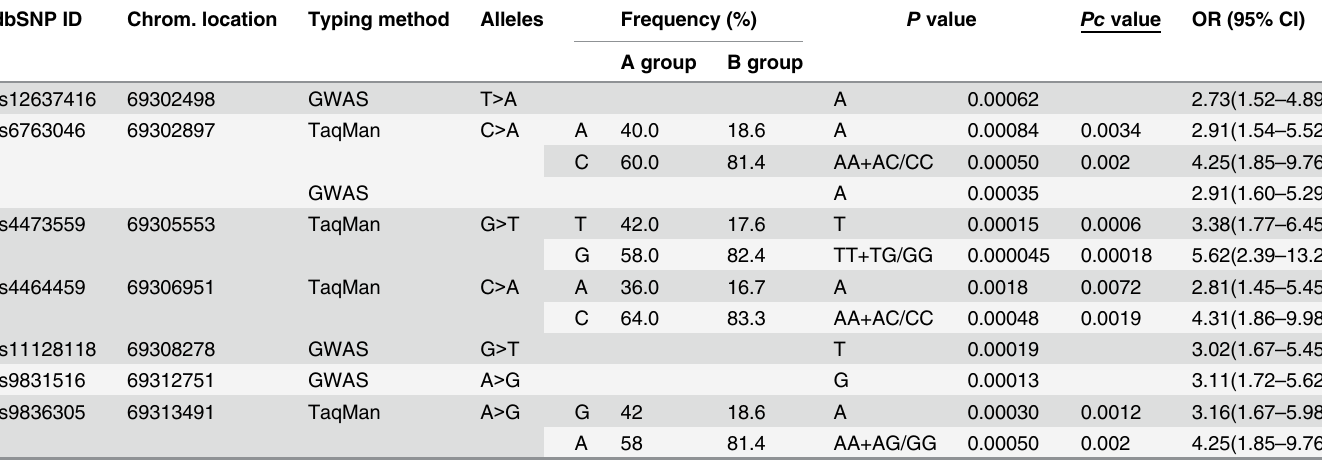
Table 4. Association analysis of single nucleotide polymorphisms in the FRMD4 gene. dbSNP ID Chrom.